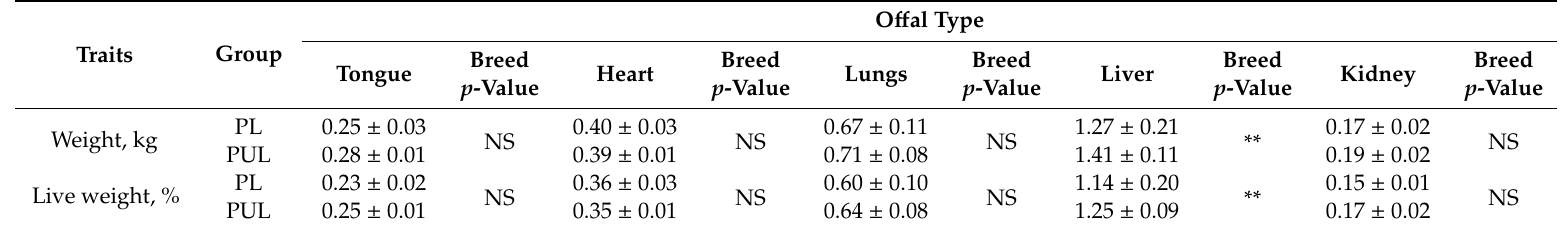
Table 2. Weight and percentage of di ff erent o ff als in live weight of pigs (mean ± SD).